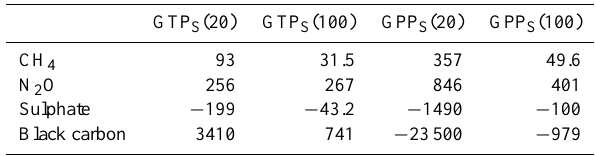
Table 3. The GTP S and GPP S , relative to CO 2 , for sustained emis- sions of four other species at time horizons of 20 and 100 years, which are chosen for illustrative purposes. The absolute values of metrics for CO 2 are given in Table 1.